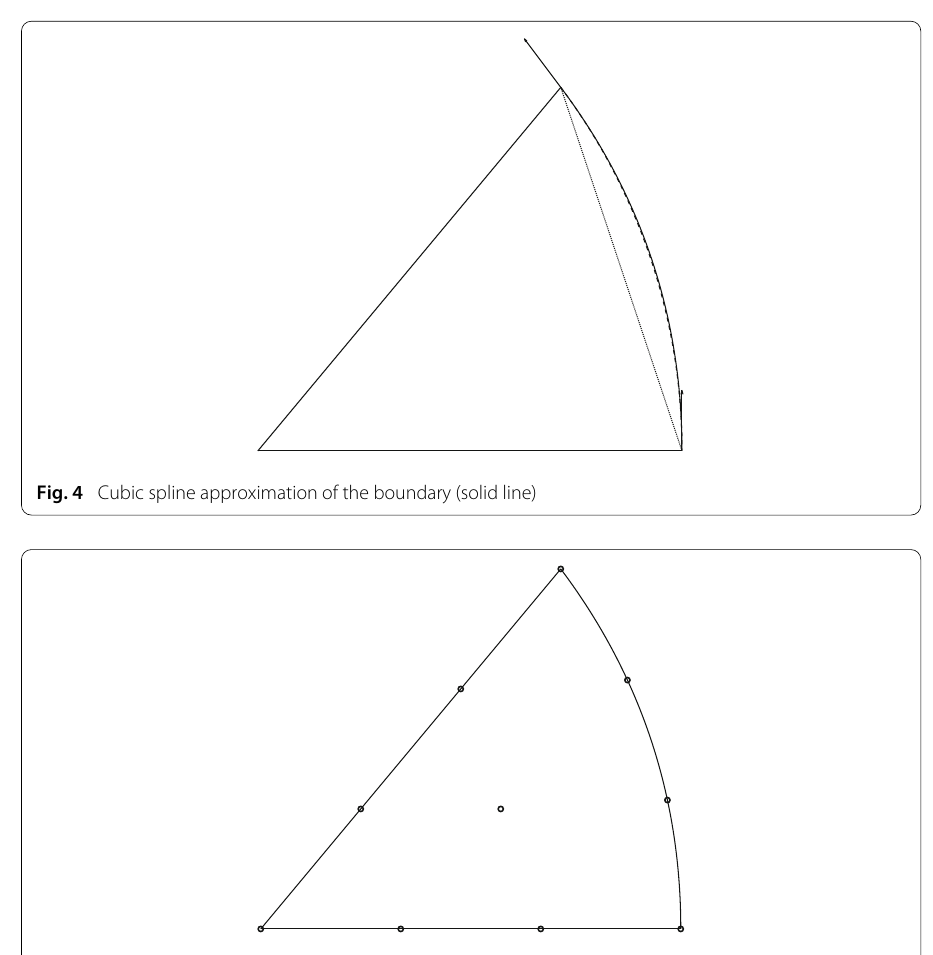
Fig. 5 Isoparametric cubic triangle approximation of the geometry